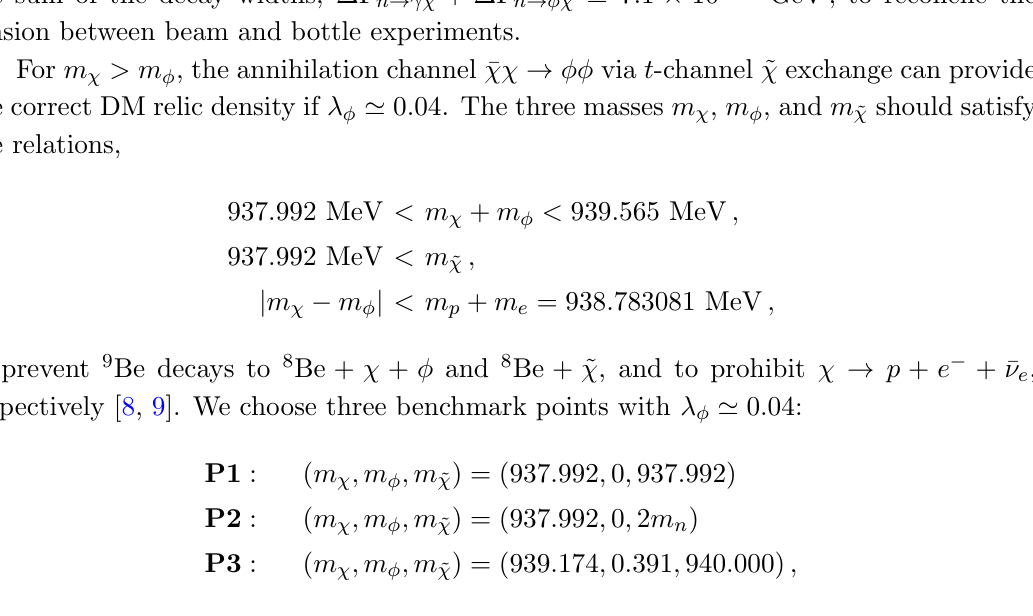
φ + γ + π 0 in Model →